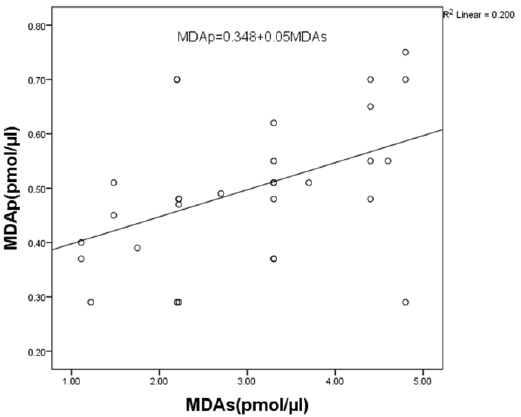
Figure 2. Correlation between MDA levels in saliva and plasma in periodontitis patients. Statistically significant at p < 0.05. MDAp—malondialdehyde in plasma; MDAs—malondialdehyde in saliva.